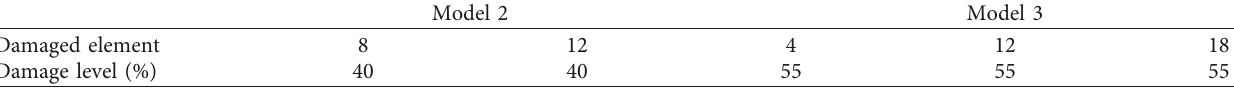
Table 6: Elements with corresponding damage level of images for the noise robustness assessment.